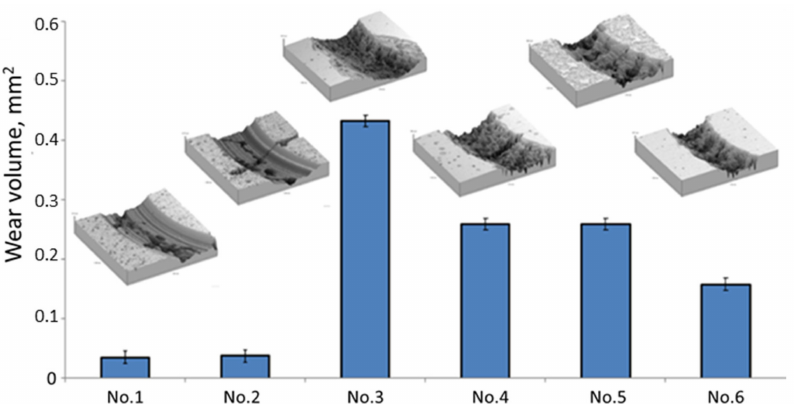
Figure 9. The wear volume of (TiZrNb)N coatings with the transverse profile of the wear